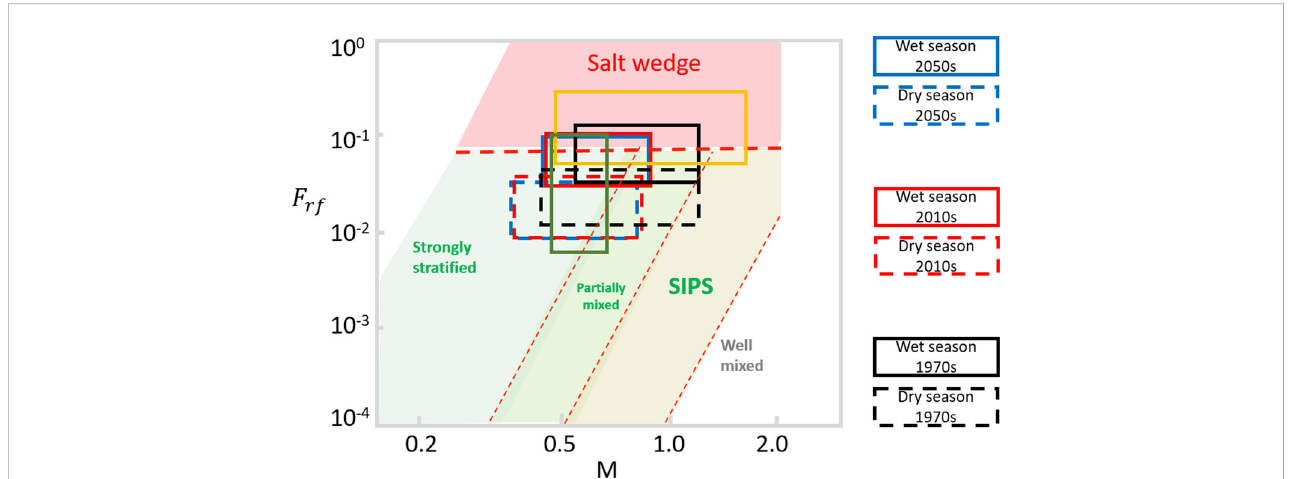
FIGURE 11 Estuarine parameter space with the freshwater Froude number ( F rf ) and mixing number (M). The red solid line calculated from a − 1 = 2 F − 1 = 3 rf M 2 ≈ 1, in which a =3.4, which divides the estuarine parameter space into estuaries that always remain strati fi ed and those that experience boundary-generated mixing during a tidal cycle. The location of PRE in different ages and different seasons are indicated in the fi gure. The yellow rectangle is the location of North passage Yangtze River according to Chen (2018); the green rectangle represent the Hudson River according to Geyer and Maccready (2014). SIPS is Strain-Induced Periodic Strati fi cation. Modi fi ed from Geyer and Maccready